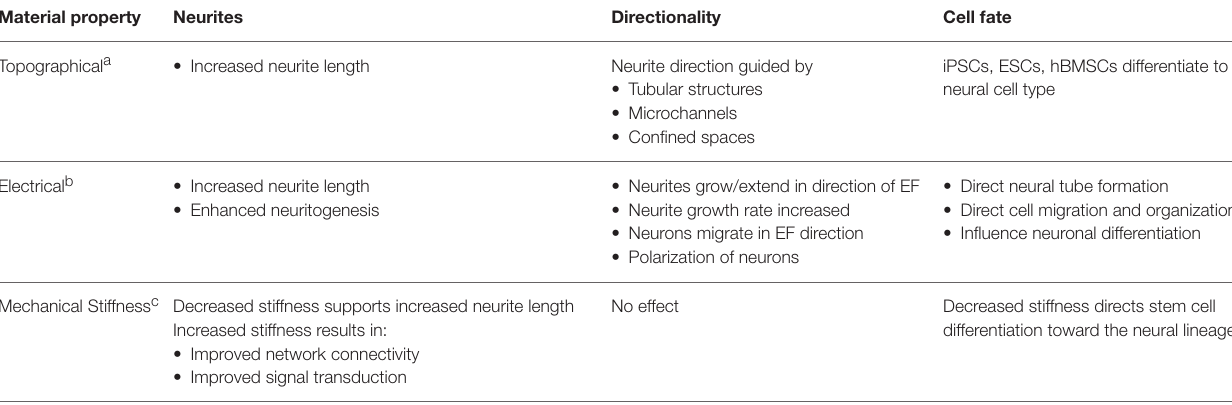
TABLE 1 | Impact of various material properties on neuronal behavior and development. Material